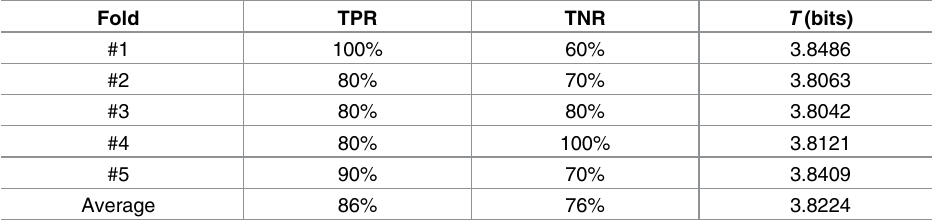
Table 2. 5-fold cross-validation (80/20).